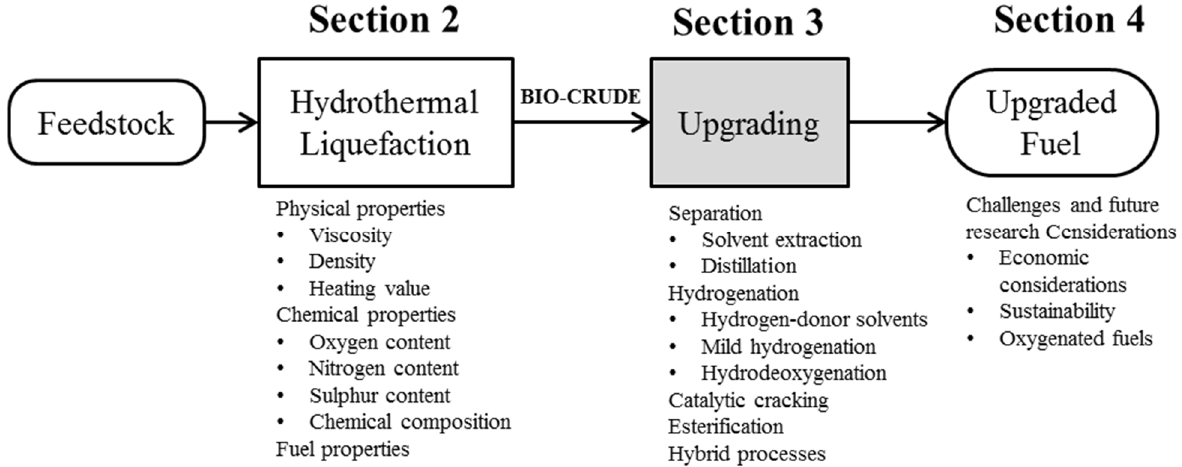
Figure 1. Thermochemical process conceptual diagram and outline of the